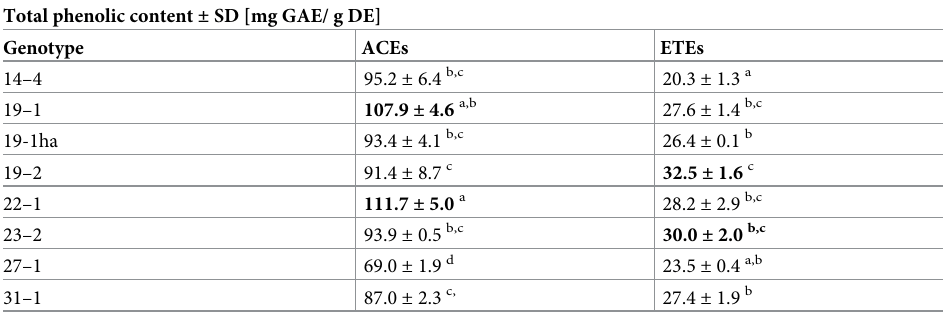
Table 1. TPC of the ACEs and ETEs of U . molinae fruits from different genotypes assessed by FC method.